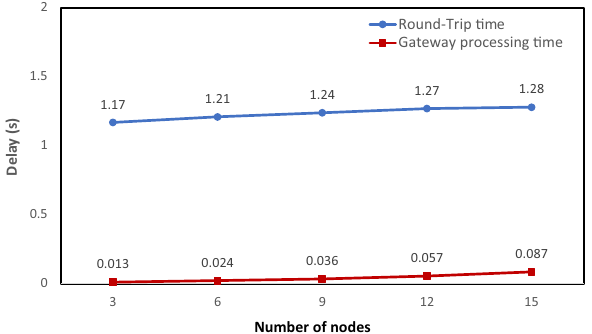
Figure 23. Latency and processing delay as a function of the number of